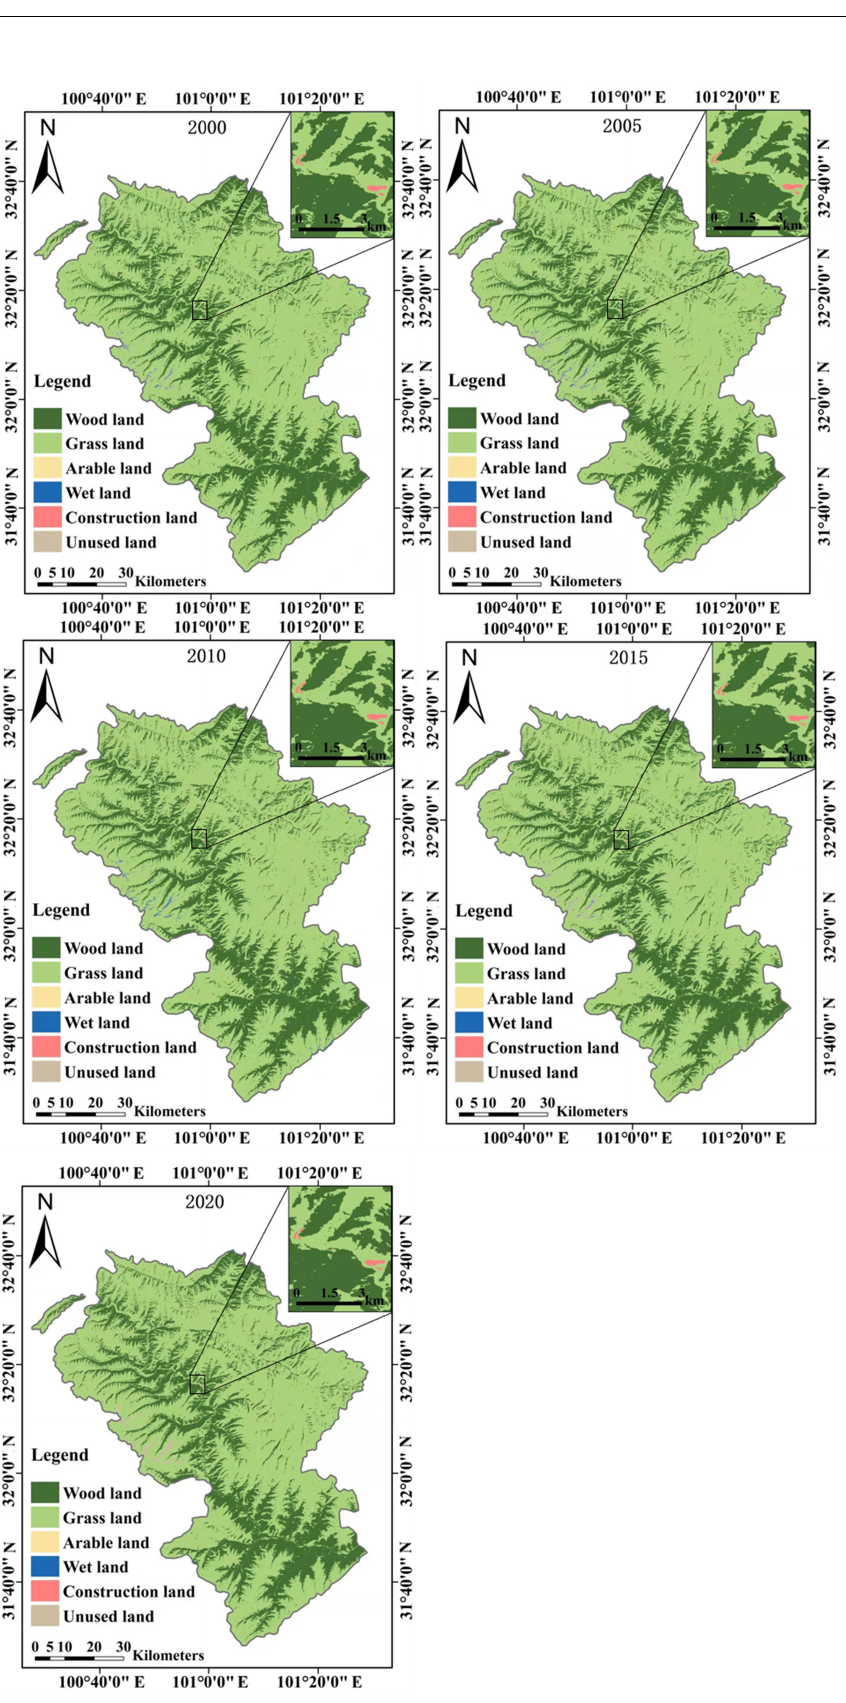
Figure 5. Land use type of Rangtang